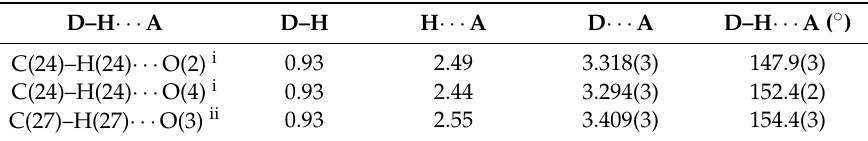
Table 2. Intermolecular hydrogen bonds for compound 1 (Å, ˝ ).